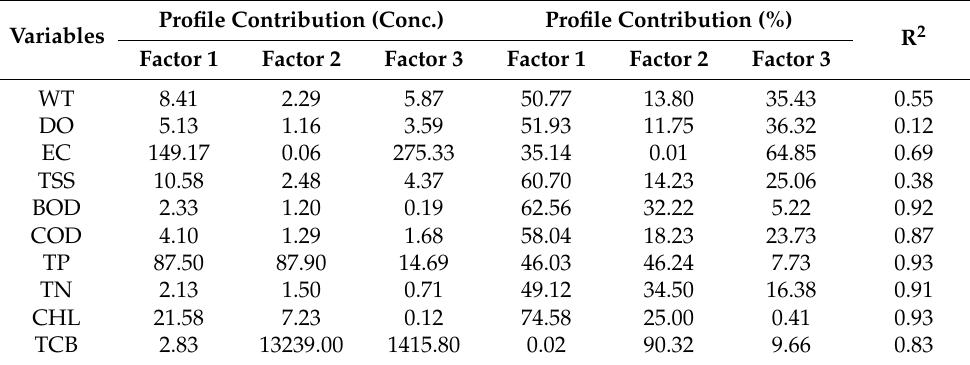
Table 2. Source apportioning contributions for water quality variables in the Yeongsan River using the positive matrix factorization